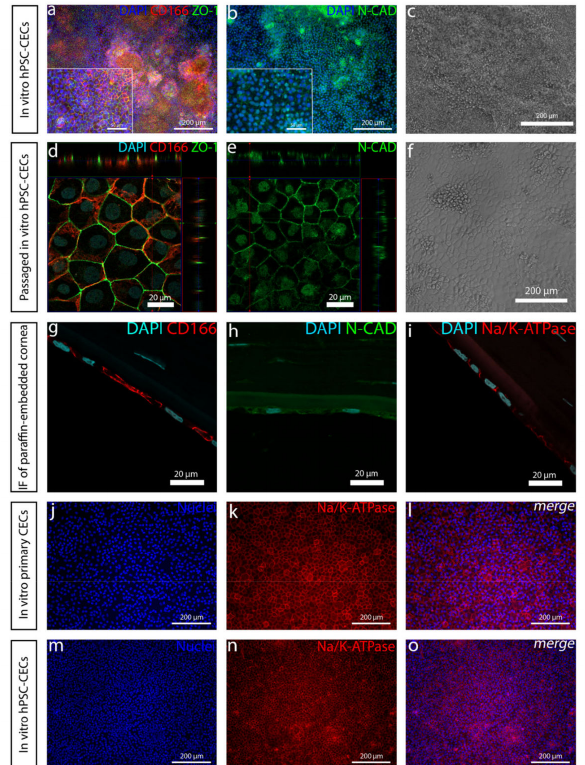
Figure 7. Passaging of the cells refines the cell culture, and the PSC-CEnC-like cells significantly resemble primary CEnC cells. ( a ) Immunofluorescence images of the expression of ZO-1 and CD166 in hPSC-CEnCs at day 8. ( d ) Day 8-passaged hPSC-CEnC-like cells at day 13 and ( g ) primary CEnCs show how the passaging refines the cells and how the differentiated cells resemble primary CEnCs. ( e ) N-cadherin is enhanced in day 8-passaged hPSC-CEnC-like cells at day 13 compared to ( b ) unpassaged day 8 cells. ( c , f ) Phase contrast light microscope images show how the cell culture is refined with more hexagonal cells after the passage. ( i ) The expression and localization of Na + /K + - ATPase are very similar in histological paraffin-embedded endothelium, ( j – l ) in vitro primary CEnCs and ( m – o ) differentiated PSC-CEnC-like cells at day 8. hPSC-CEnC-like cell data was conducted with the Regea08/017 hESC line. Scale bars: ( a – c , f , j – o ) 200 µ m, ( a , b magnified images) 50 µ m and ( d , e , g – i ) 20 µ